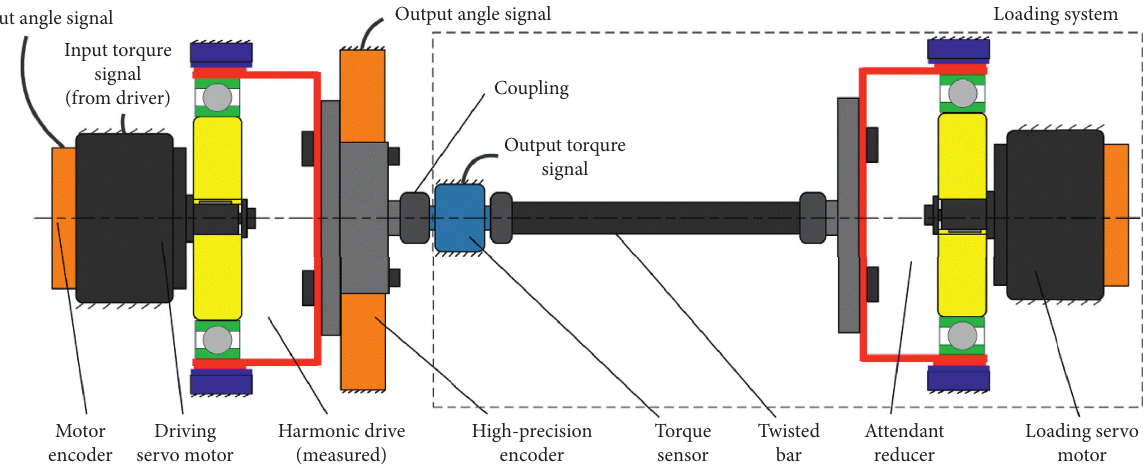
Figure 4: Schematic diagram of the experimental apparatus.